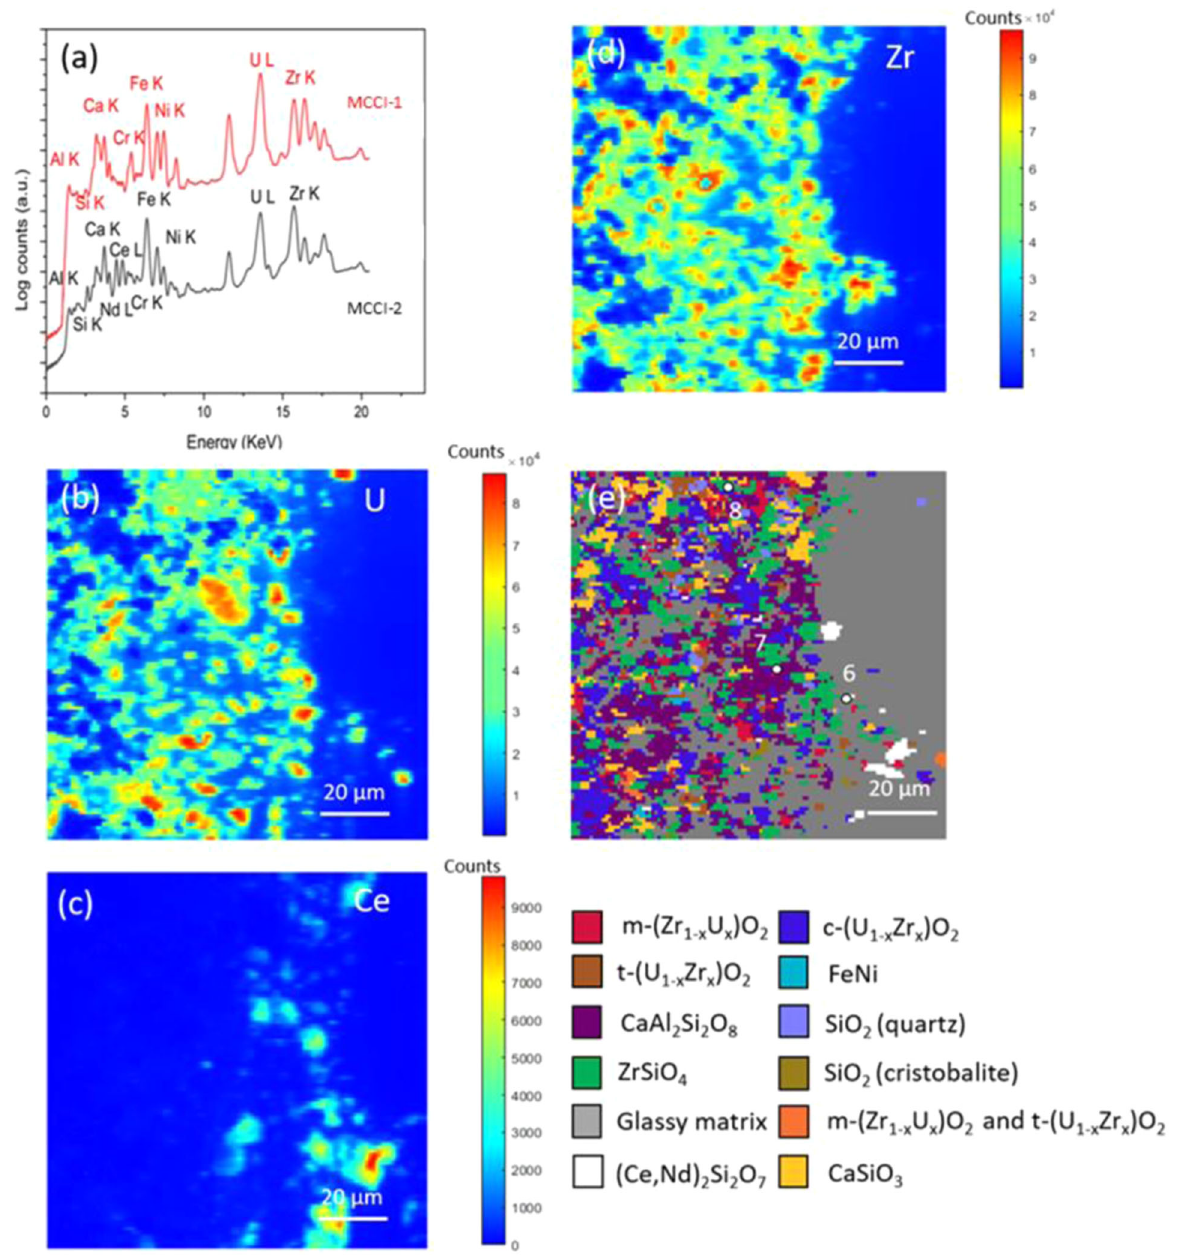
Fig. 4 Micro-focus X-ray analysis of MCCI-2. Showing a normalised and stacked XRF spectra comparing MCCI-1 and MCCI-2; distribution of b U-L α X-ray fl uorescence signal, c Ce-L α X-ray fl uorescence signal, d Zr-K α X-ray fl uorescence signal; and e 2D µ-diffraction map of MCCI-2 reconstructed from XRD patterns taken at each individual pixel in the µ-XRF maps shown in a . The white points labelled 6 – 8 in e indicate the locations of interest that XANES spectra were collected from, detailed in Fig. 7. Scale bar on all images is 20 µm. higher energy, relating to an estimated oxidation state of 4.32 ± the UO 2 reference compound. The estimated oxidation states 0.10 and 4.37 ± 0.10. The variation of average U oxidation states were between 4.00 ± 0.10 and 4.22 ± 0.10, indicating that U was within the glass matrix and crystalline phases of simulant MCCI mainly present as U 4 + in the different phases of the U 1 − x Zr x O 2 products are similar to our previous study of Chernobyl LFCM solid solution. The whiteline of the XANES spectrum of point 8, simulants 17 . Given that corrosion and formation of U-containing located in a particle of zircon, showed a slight shift to a lower energy position compared to UO 2 . This observation is in secondary phases 27 – 30 , involving changes of U oxidation state, has accordance with the predicted effect of silicate anions on the U occurred during the last 35 years for Chernobyl LFCMs, this local environment and XANES spectra, and is in good agreement observation might be useful for prediction and further manage- with the U L 3 edge XANES of the reference compound USiO 4 , ment of Fukushima MCCI products. Representative crystallites of c-(U 1 − x Zr x )O 2 and Zr 1 − x U x SiO 4 were cof fi nite, which is the U-end member of zircon (ZrSiO 4 ). In contrast, the U L 3 µ-XANES spectrum of U within the glass matrix further analysed by fi tting of the U L 3 Extended X-ray Absorption (points 3 and 6) displayed a clear shift of the whiteline to slightly Fine Structure (EXAFS), as shown in Fig. 8. The k 3 -weighted EXAFS Published in partnership with CSCP and USTB npj Materials Degradation (2022)